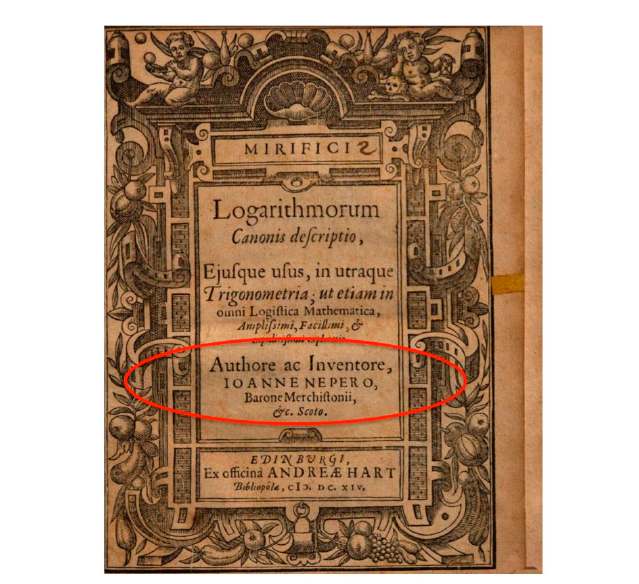
Figure 8. Title page from John Napier’s Logarithmorum Canonis Descriptio (Andrea Hart, 1614).